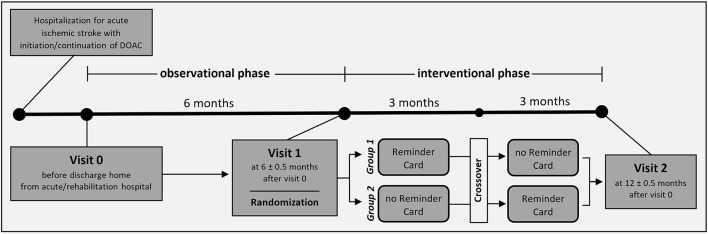
Study flowchart.